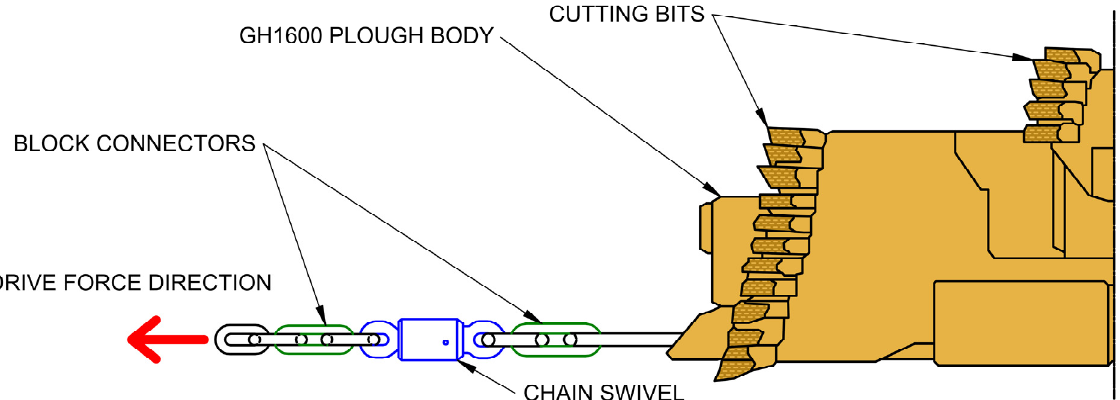
Figure 3. Location of the chain swivel in the coal plough system.